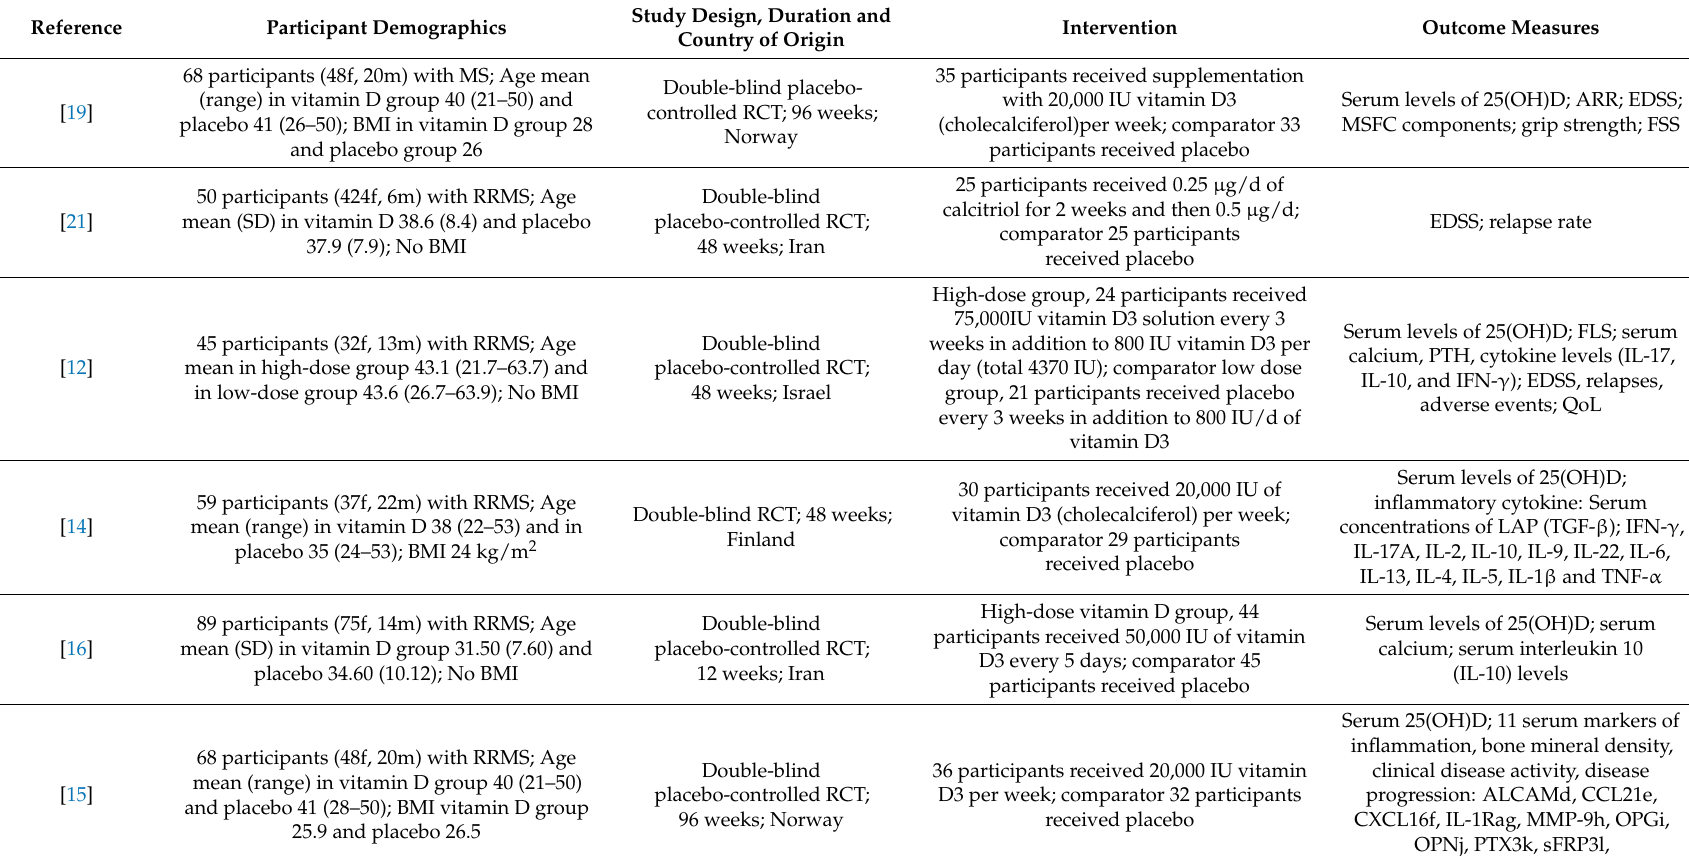
Table 2. Characteristics of selected